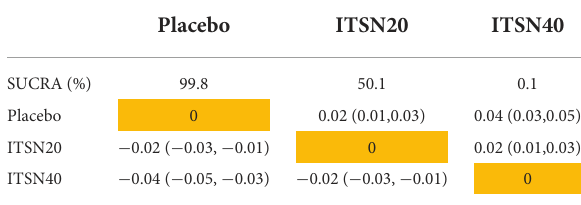
TABLE 4 Matrix of pairwise comparison among hypoglycemic drugs on ADCS-ADL scale score (shown as mean difference and 95% confidence intervals).